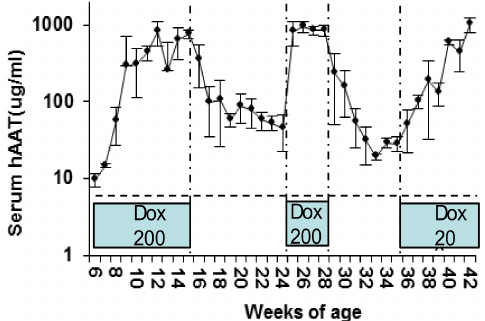
Figure 2. Regulated hAAT levels in C57BL / 6 mice. Animals ( n = 4) received intramuscular (IM) injection of rAAV1-tet-on-hAAT vector (2 × 10 11 vg / mouse) at 6 weeks of age. Dox-containing chow (200 µ g / kg) was provided from 6–15 weeks of age, and replaced by normal food without Dox between 16 and 23 weeks of age. From 24 to 28 weeks of age, animals were fed Dox-containing chow (200 µ g / kg). Animals received low Dox-containing chow (20 µ g / kg) from 35 to 42 weeks of age, as indicated in the blue boxes.